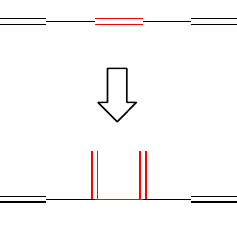
Figure 5. Horn growing.